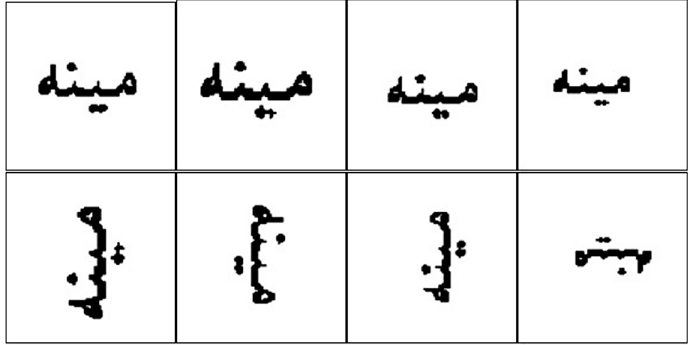
Fig 4. Scale and orientation variations in Pashto image